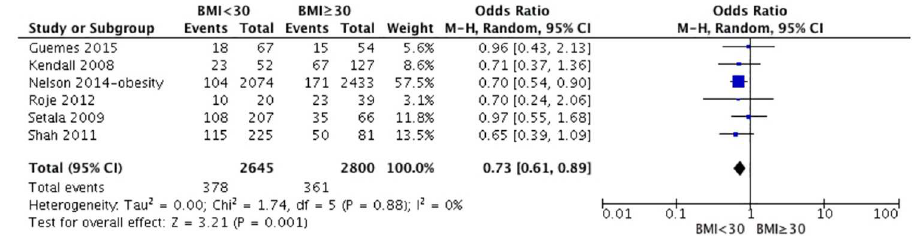
Fig 2. Correlations between BMI and complications.